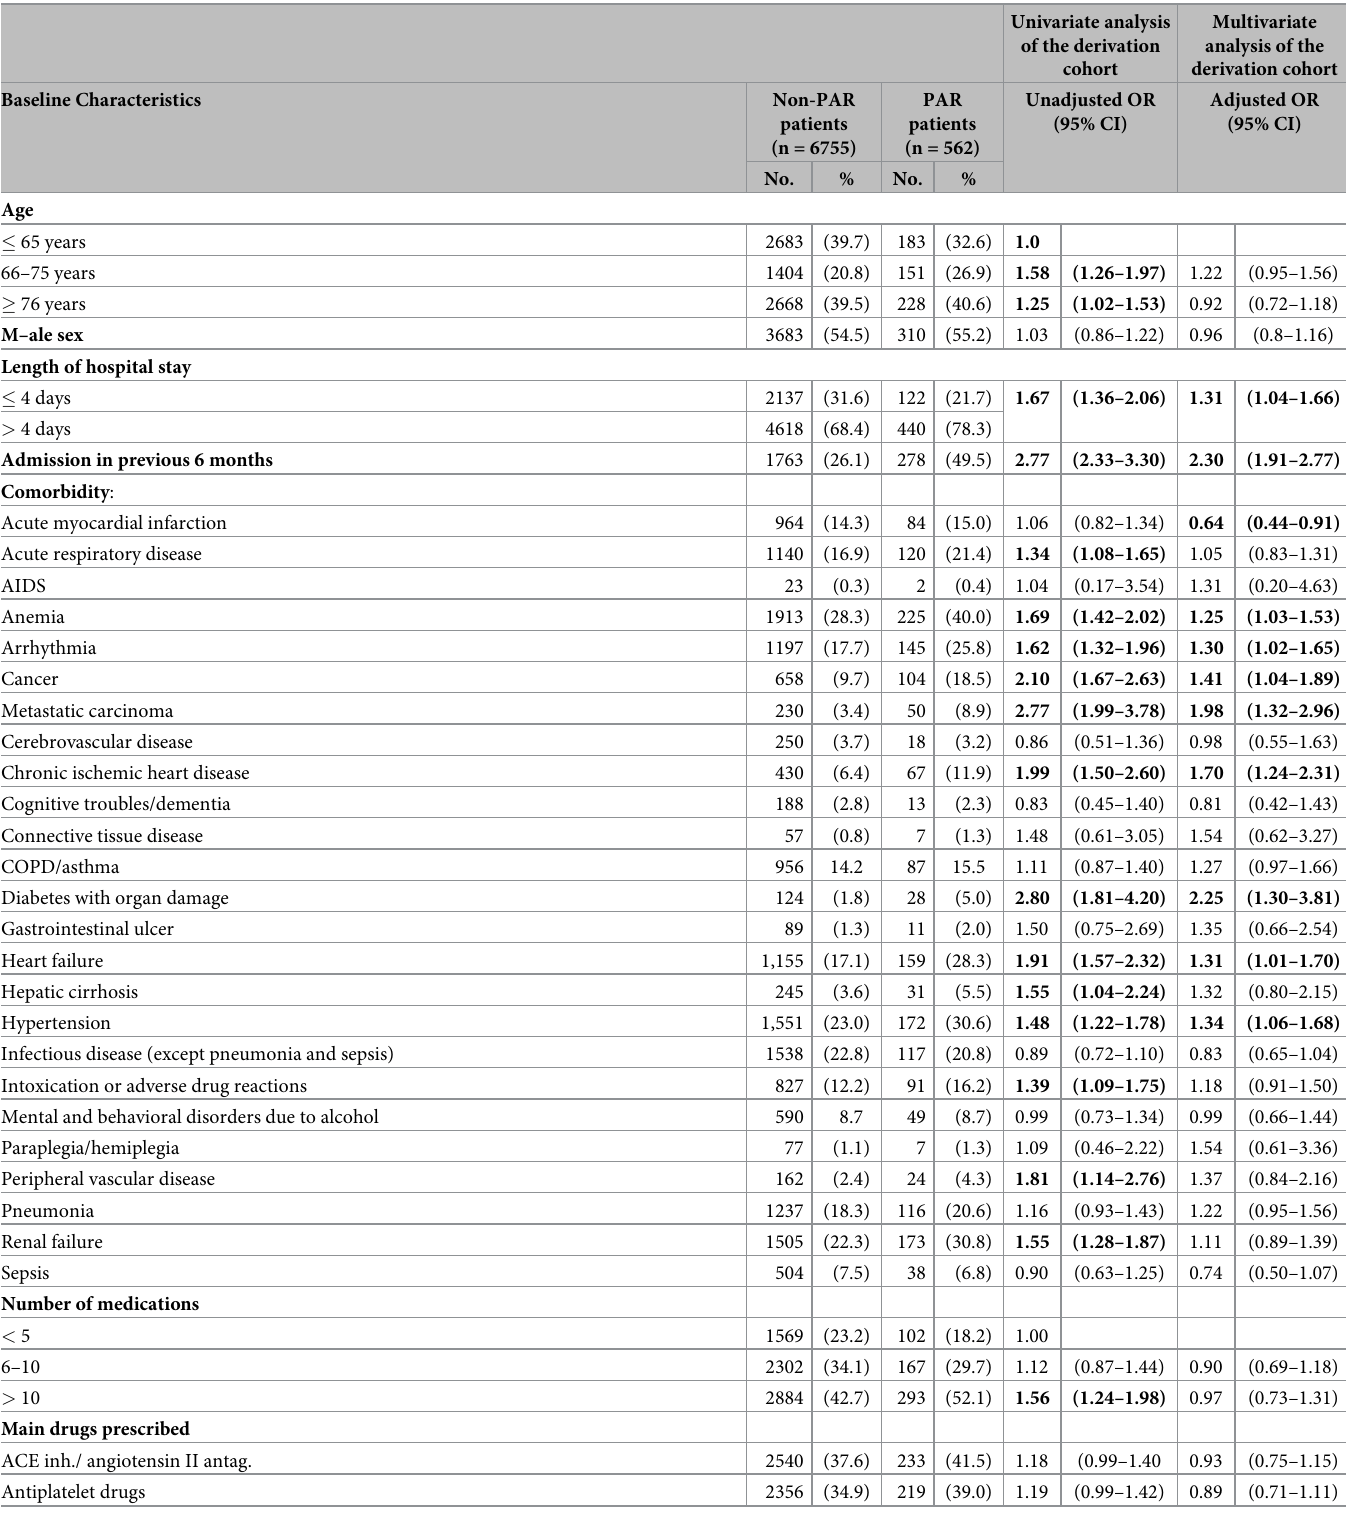
Table 2. Univariate and multivariate analyses of the derivation